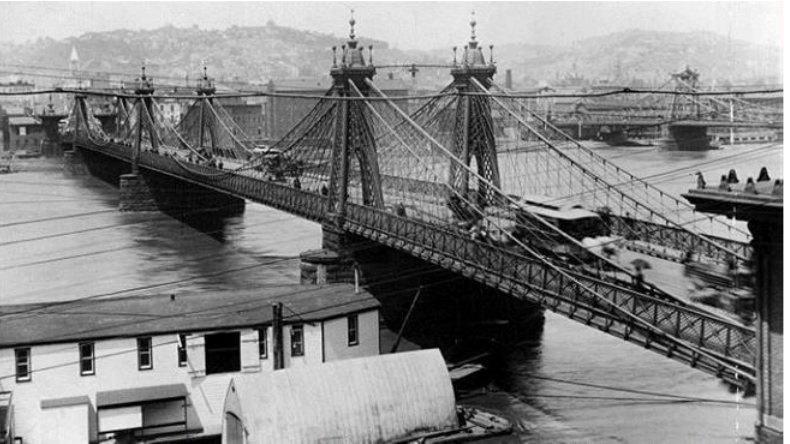
Figure 16. Monongahela Bridge, Continuous Span Compensation Suspension Structure. Designed by Roebling. Pittsburgh. 1846. Source: The Carnegie Library of Pittsburgh.